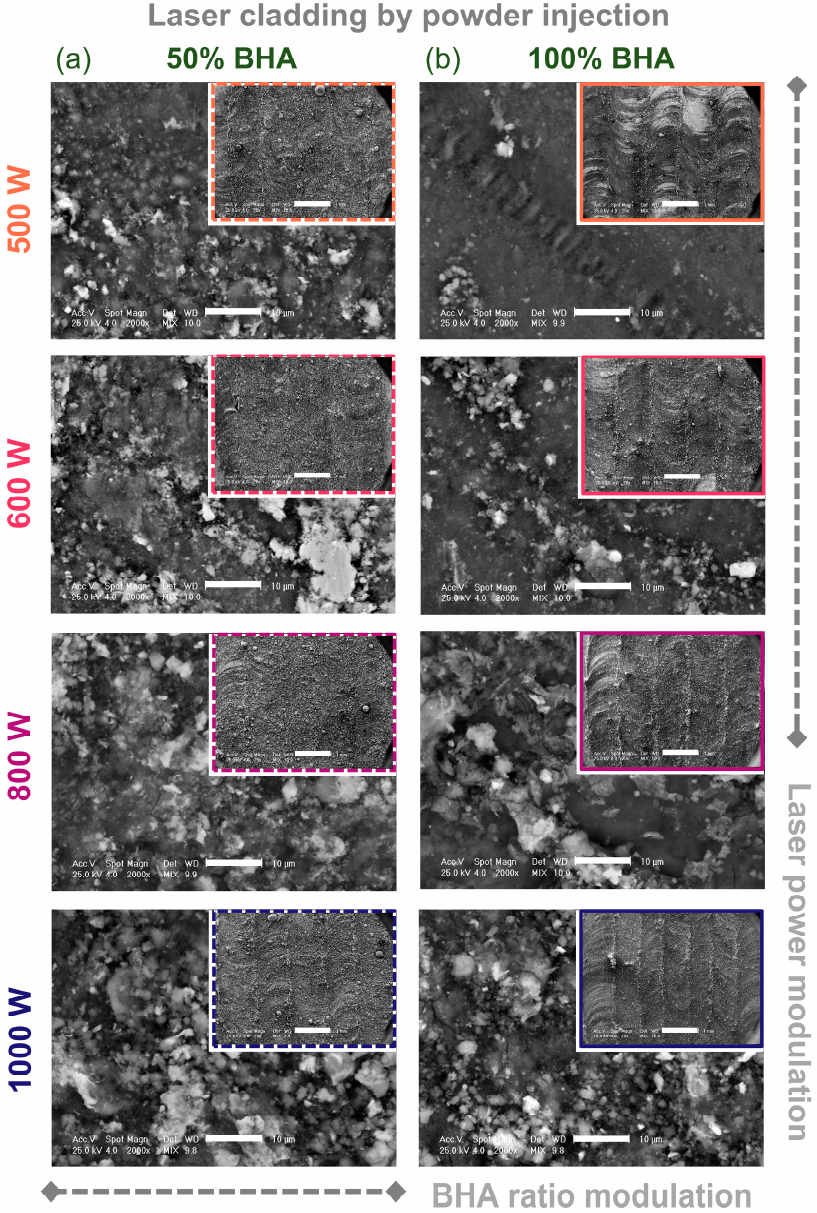
Figure 4. SEM morphological evaluation of the laser cladded samples deposited using BHA powder contents of ( a ) 50 and ( b ) 100 wt.% at the four beam powers. Scale bar: main image—10 µ m, inset—1 mm.